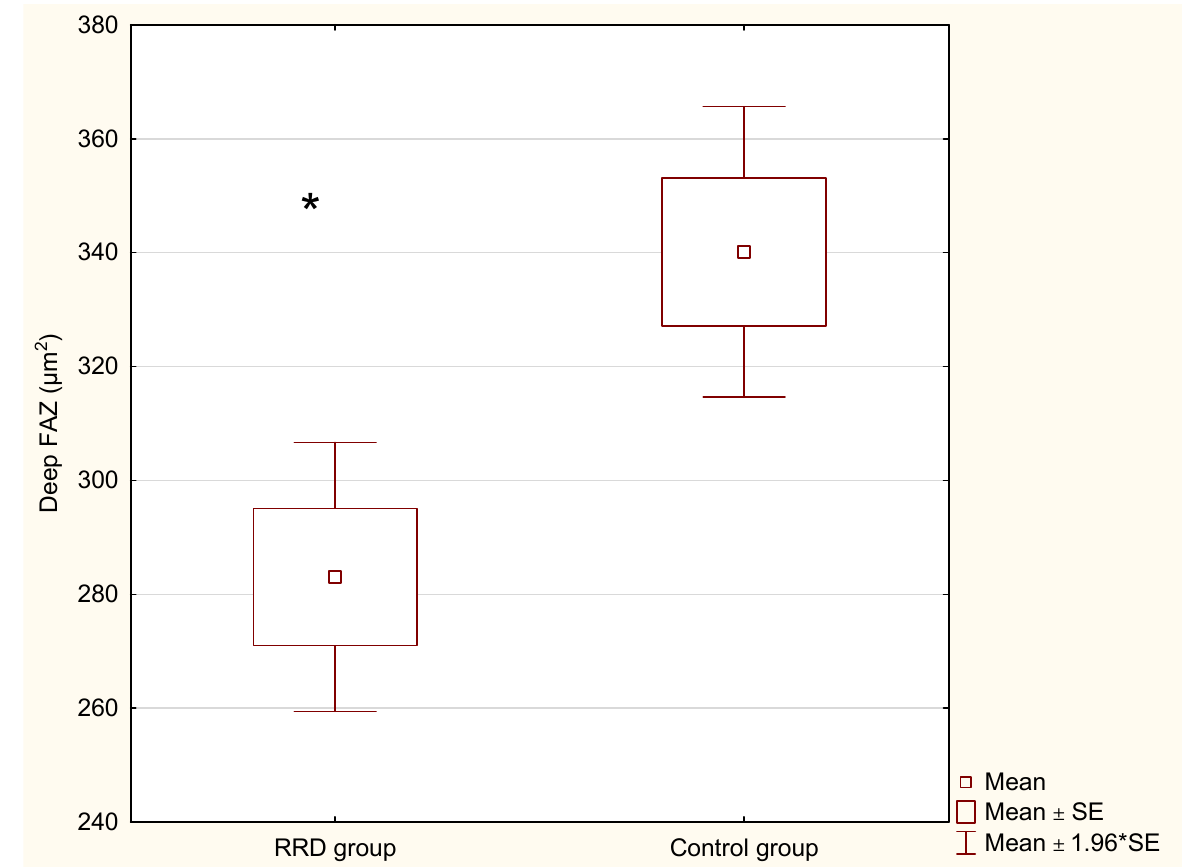
Figure 1. Changes in the deep vascular plexus of the FAZ in the RRD group and in the control group ( p < 0.05). RRD—rhegmatogenous retinal detachment group; FAZ—fovea avascular zone; * statistically significant differences in comparison to control ( p < 0.05).